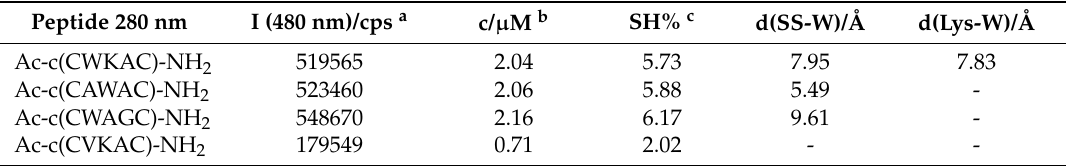
Table 5. Photodegradation results of different peptide models after 60 min illumination at 280 nm. The calculated MM distances are also